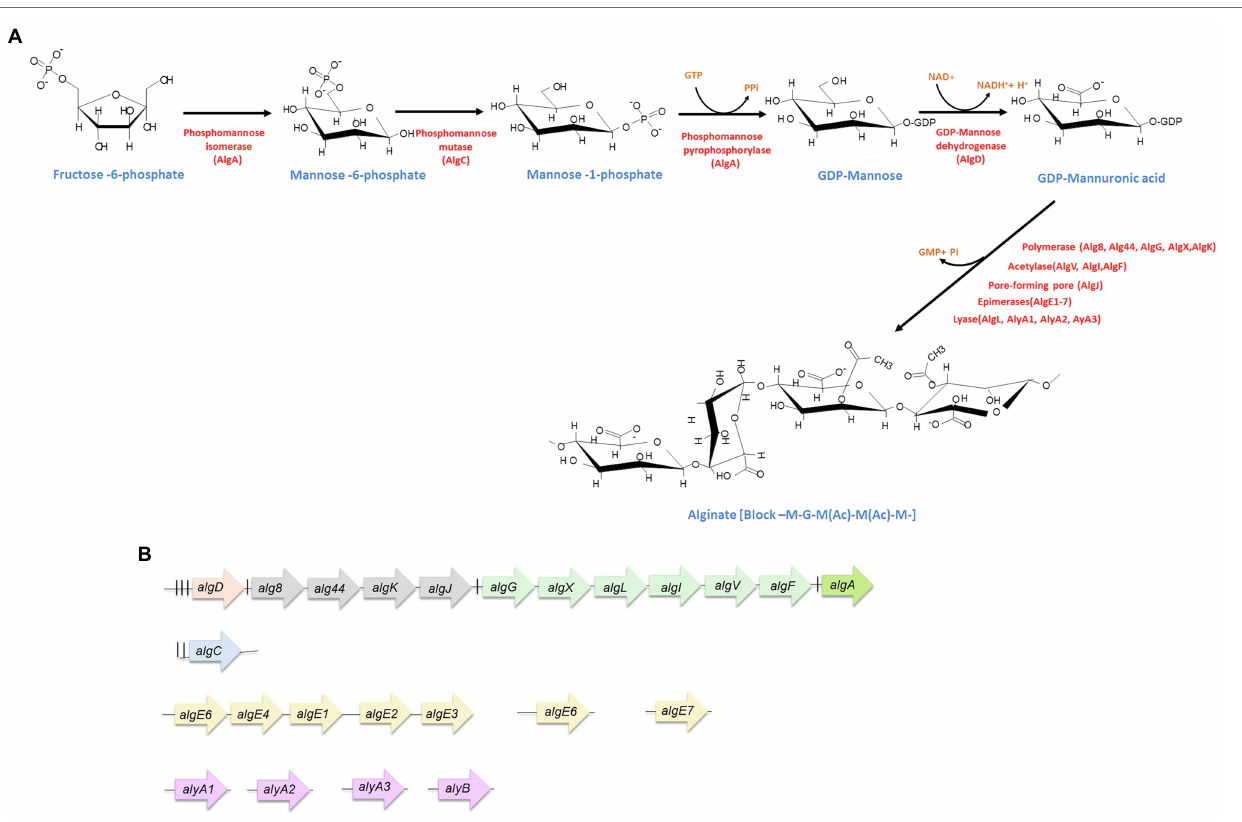
FIGURE 1 | Alginate synthesis in Azotobacter vinelandii . (A) Biosynthetic pathway. The enzymes (red) as well as the substrates (blue) for alginate production are indicated. (B) Genetic arrangement of alginate biosynthetic genes. The experimentally determined promoters are indicated by vertical black lines. algD transcription starts from three promoters (for details, see the text). The nature of the internal promoters upstream alg8, algG , and algA is unknown. Genes are not shown at